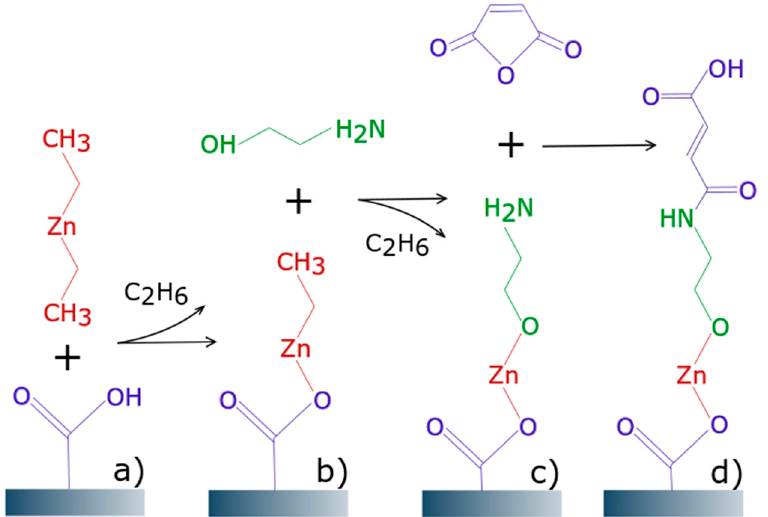
Figure 1. MLD (molecular layer deposited) reaction scheme: ( a ) Diethyl zinc (DEZ) reacting with surface hydroxyl group coming from the previous cycle; ( b ) ethanolamine (EA) reacting with ethyl surface group; ( c ) maleic anhydride (MA) ring-opening reaction; ( d ) monolayer formed after one MLD cycle.